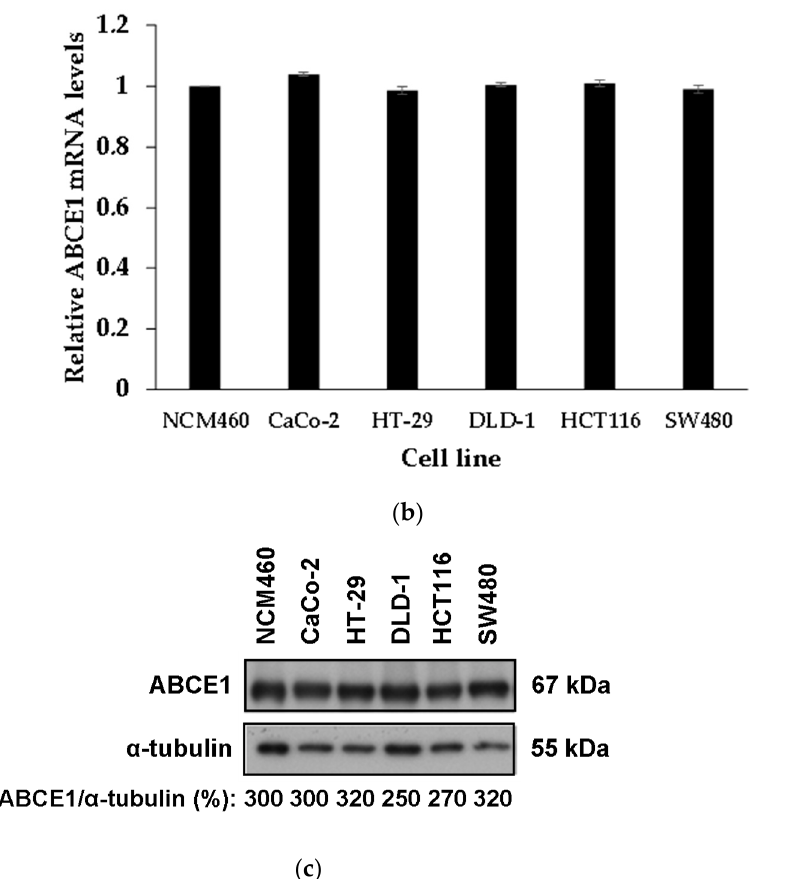
Figure 10. ABCE1 AUG uORFs and ABCE1 protein do not have an oncogenic role. ( a ) NCM460 and HCT116 cells were transiently co-transfected with each one of the constructs described in Figure 2a, and their expression analyzed as described in Figure 2b legend. The data from HCT116 cells are the one displaying in Figure 2b. The results are presented as mean ± SEM from at least three independent experiments. Student’s t-test was applied for statistical significance: p < 0.05 (*). The ABCE1 mRNA ( b ) and protein ( c ) levels were evaluated in the colorectal cancer cells lines CaCo-2, HT-29, DLD-1, HCT116, and SW480, as well as in the non-tumorigenic cell line NCM460. The ABCE1 mRNA levels were assayed by RT-qPCR and normalized to the ones of the GAPDH internal control in each colorectal cell line; ABCE1 / GAPDH ratio from each colorectal cancer cell line was compared to that of NCM460 cells. The results are presented as mean ± SEM from at least three independent experiments. The protein levels were obtained by Western blot using a specific antibody against ABCE1. Alpha-tubulin was used as a loading control. This is a representative immunoblot from at least three independent experiments.